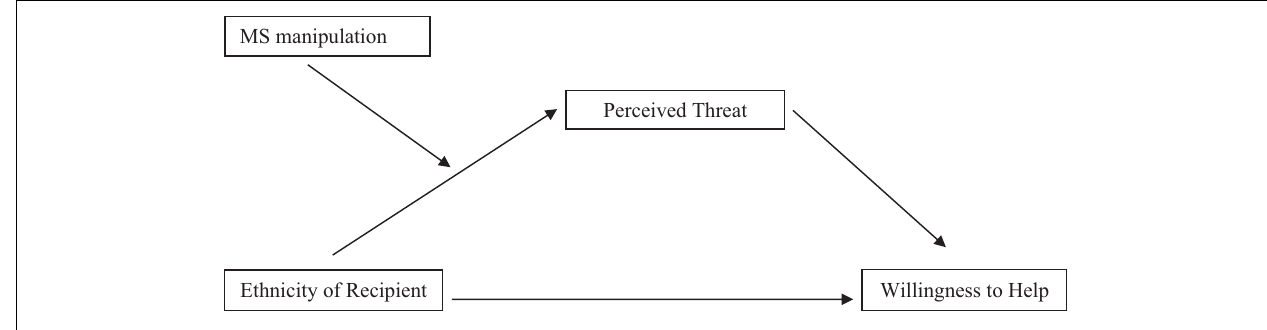
FIGURE 3 | The study’s moderation-mediation